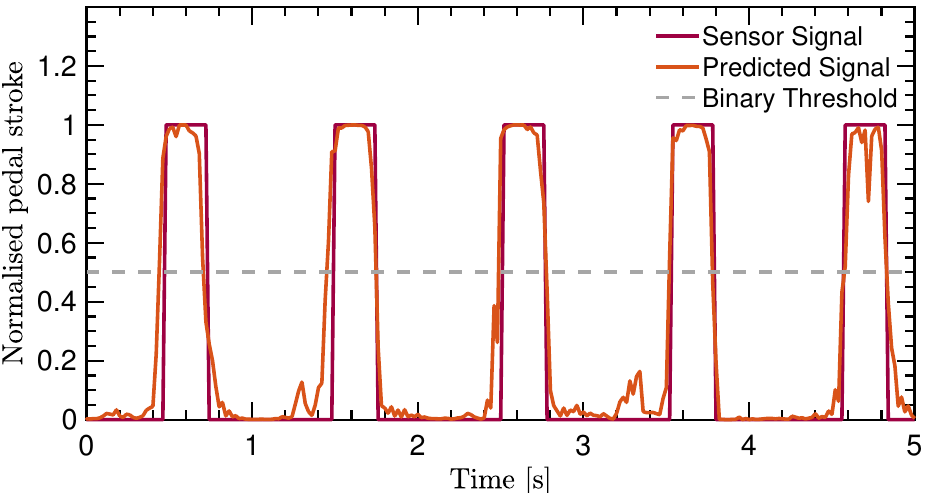
Figure 4. Pedal stroke signal from the Hall-effect sensor after pre-processing versus the output signal predicted by the network. The binary threshold indicates the threshold used to decide if the network output is mapped to 0 or